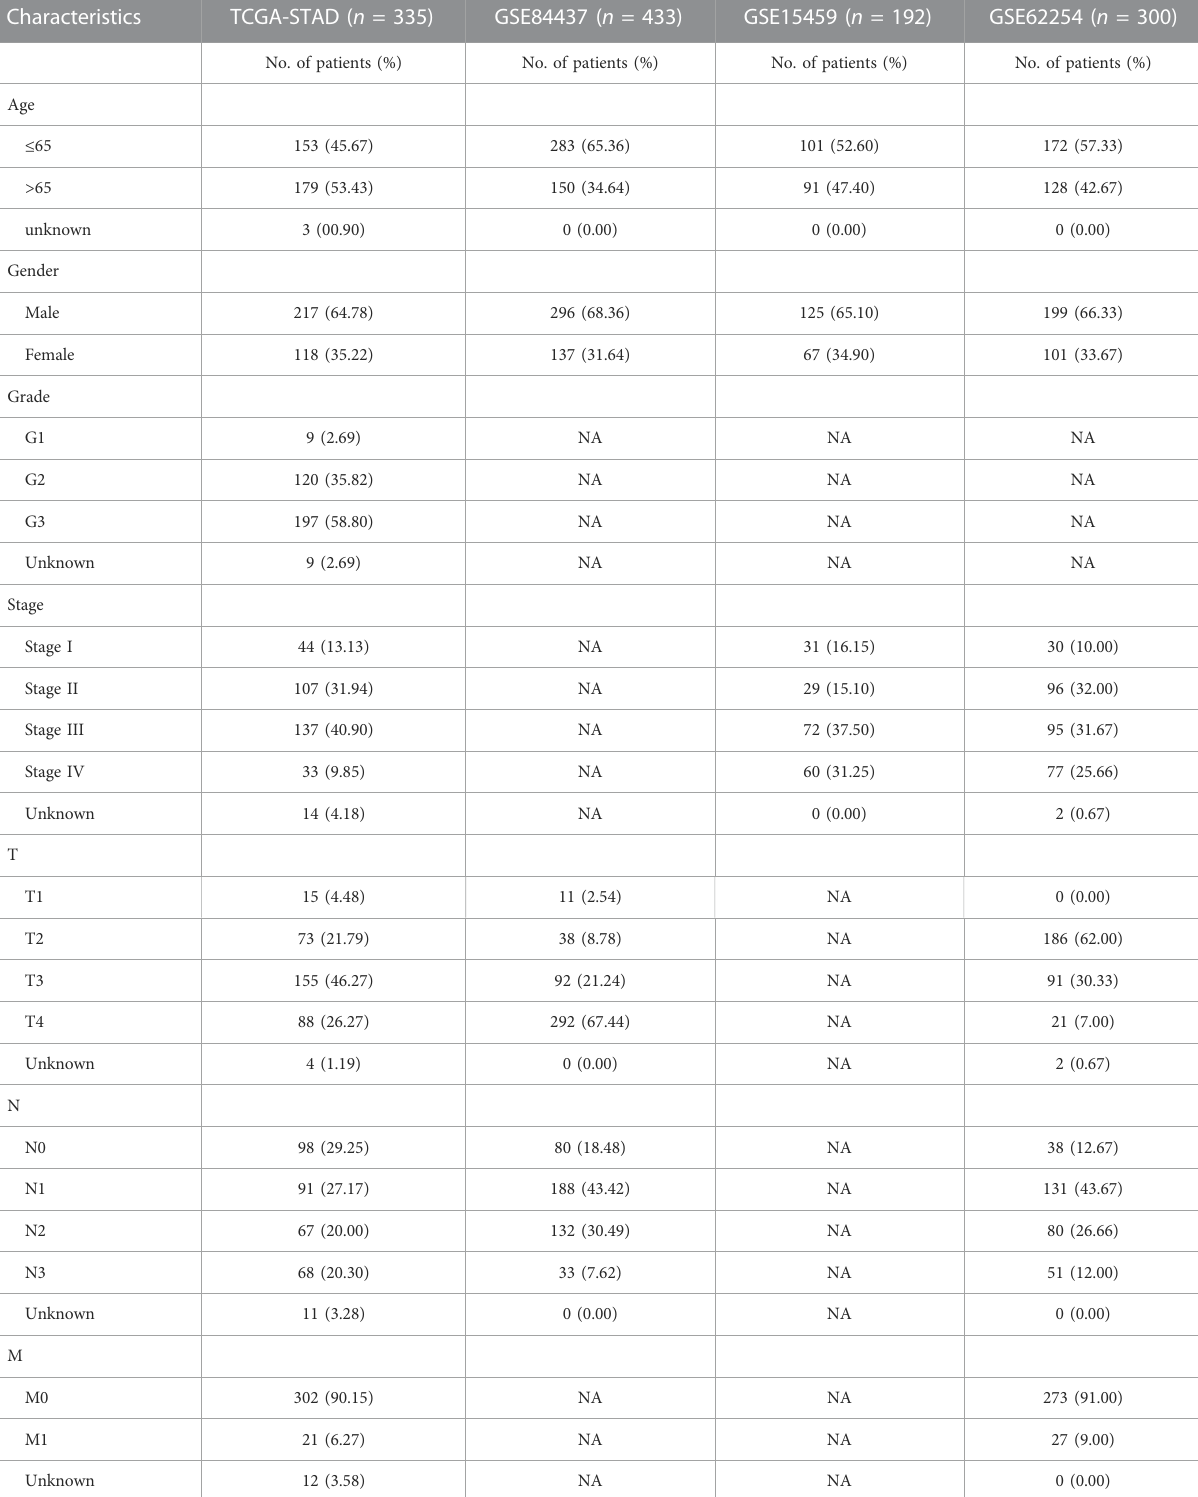
TABLE 1 Clinical characteristics of GC patients in TCGA and three GEO cohorts.